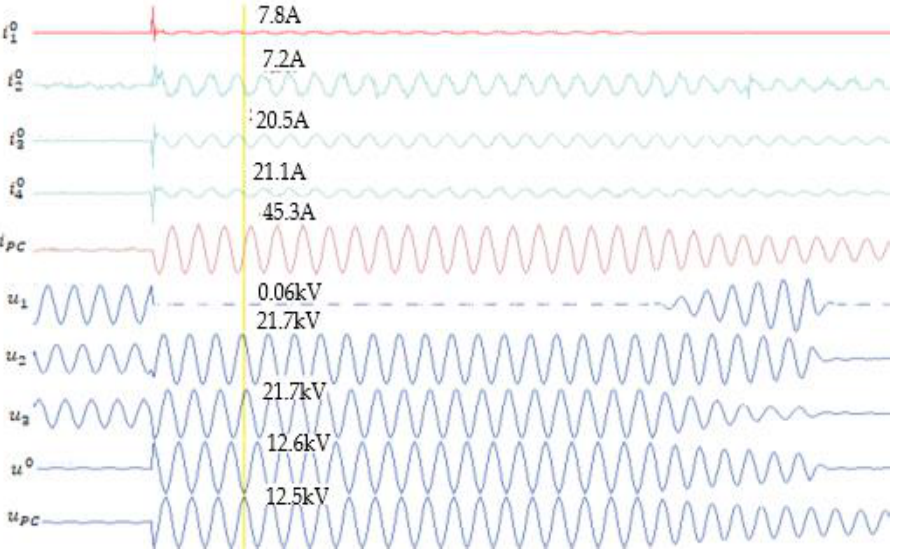
10 of 16 Figure 5. Wiring diagram of the data acquisition equipment and recording of the measured pa- rameters. The parameters were recorded with a digital recorder (CDR-10 in Figure 5). For the measurements taken in the real networks of 20 kV, command and control equipment was designed and made (control devices in Figure 5). This equipment allows